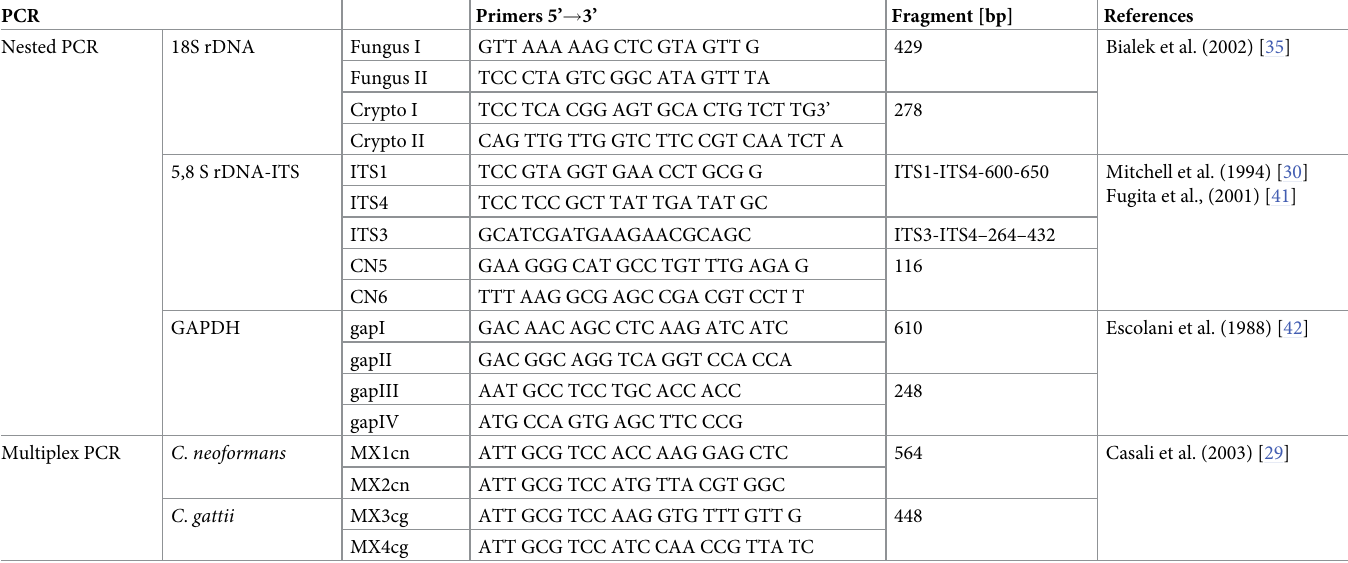
Table 1. Description of the primer’s